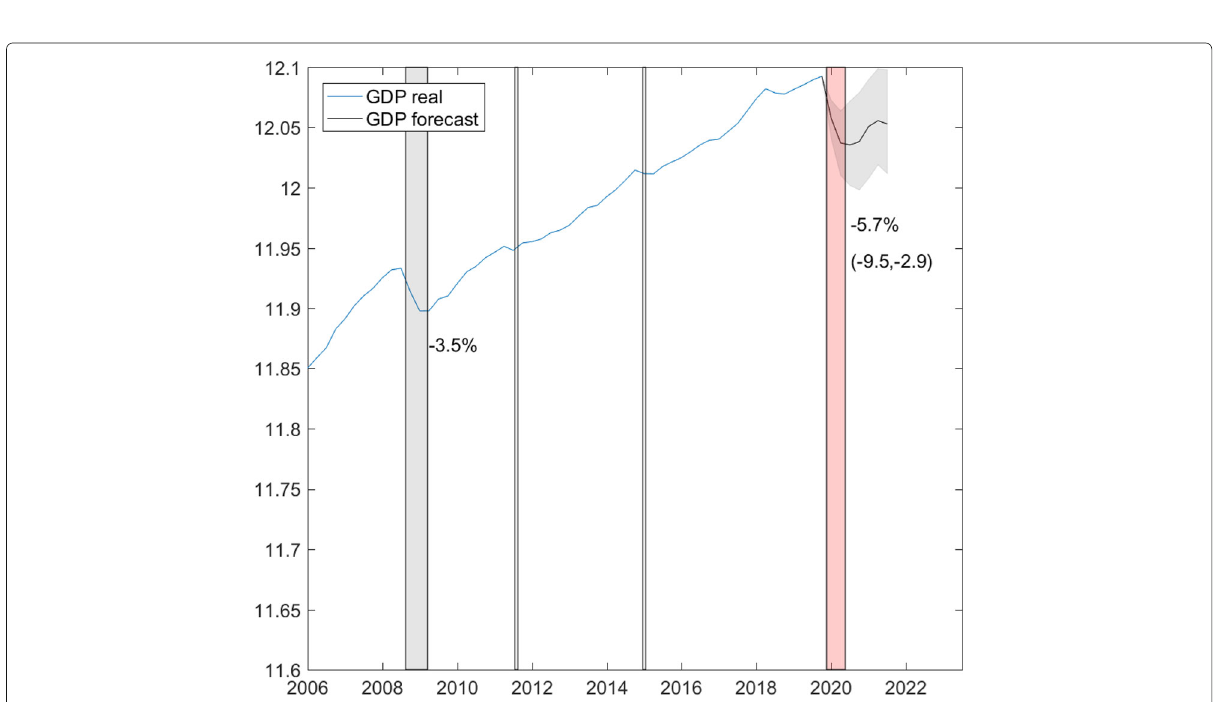
Fig. 10 Out-of-sample GDP forecast. Sample period: second quarter 2001–fourth quarter 2019. Forecast period: first quarter 2020–third quarter 2021. Gray bars highlight the financial crises, the introduction, and discontinuation of the euro-Swiss franc floor; the red bar indicates the outbreak of the COVID-19